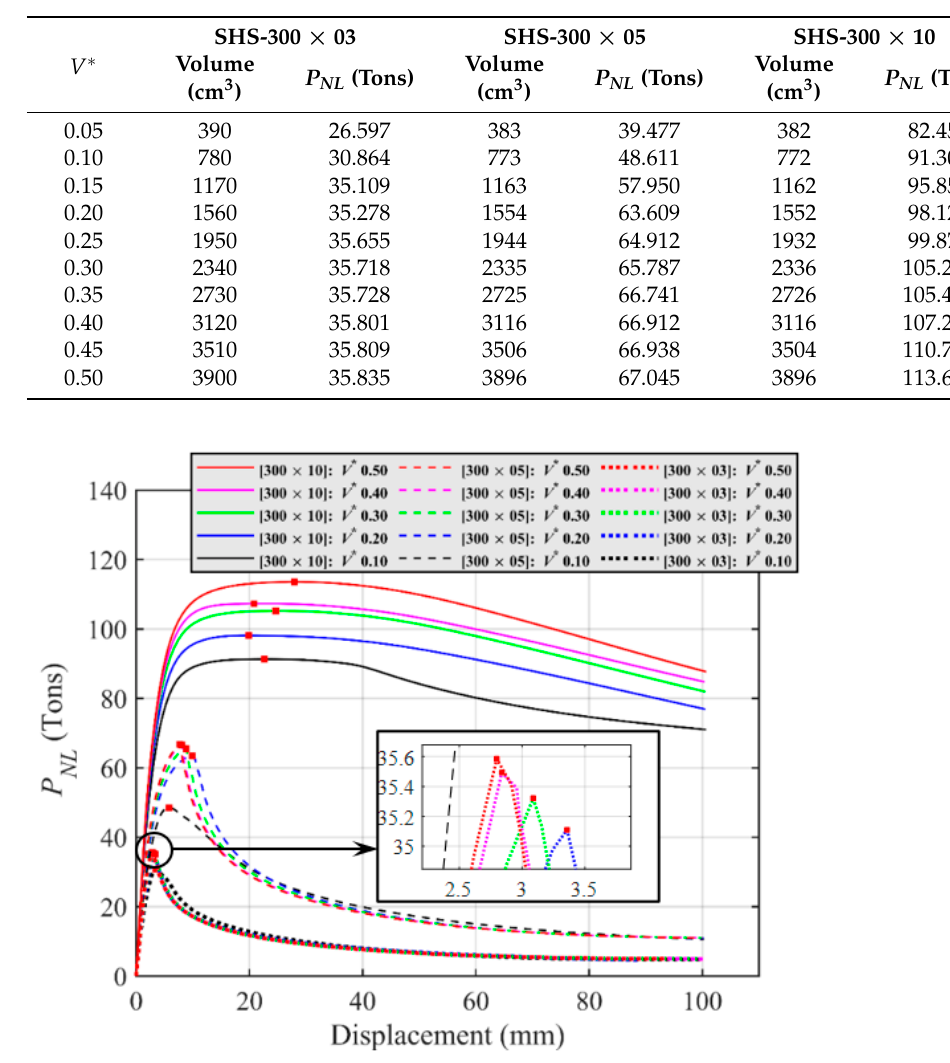
Table 3. Maximum crane loads of SHS columns with optimal-topology stiffeners.